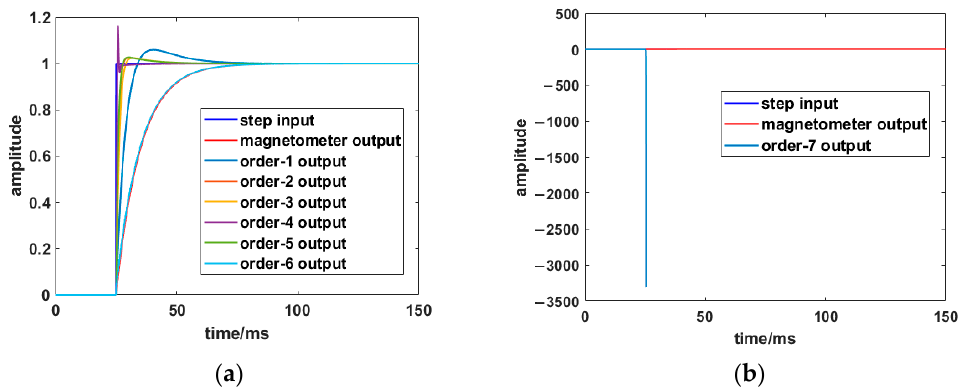
Figure 11. Dynamic compensator compensation results for different orders: ( a ) order 1 to 6; ( b ) order 7. Table 2. Dynamic compensator’s performance for different orders.